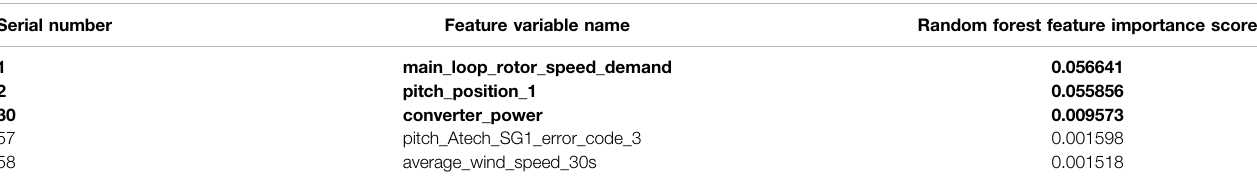
TABLE 2 | Feature importance ranking of the fault data of the pitch system based on the random forest.